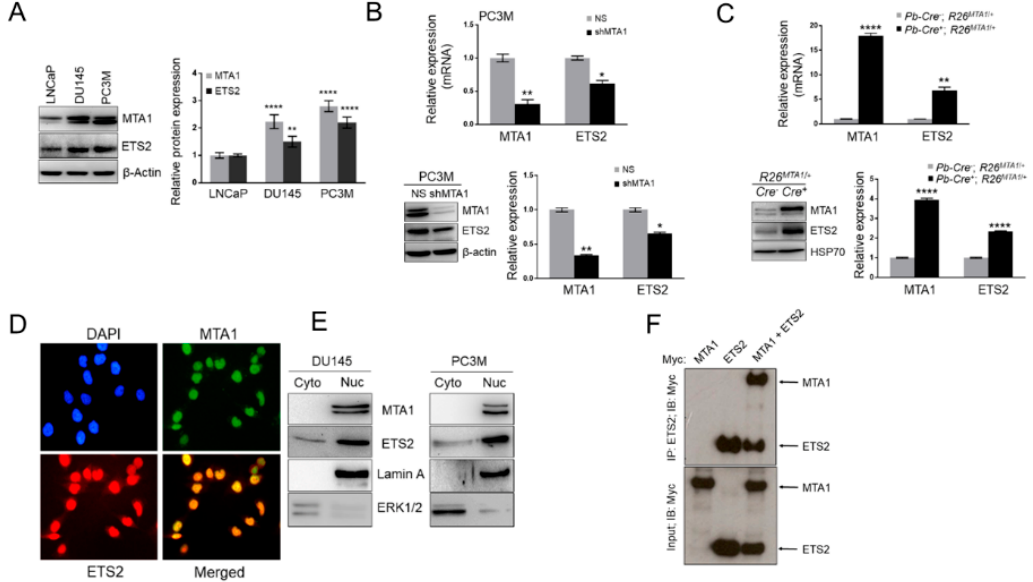
Figure 5. Erythroblastosis E26 transformation-specific 2 (ETS2) expression correlates with MTA1 in PCa. ( A ) ETS2 expression positively correlates with MTA1 expression in human PCa cell lines. ( B ) MTA1 and ETS2 mRNA ( top ) and protein ( bottom ) levels were analyzed in PC3M (NS) and silenced for MTA1 (shMTA1) cells by qRT-PCR and Western blot, respectively. Quantifications represent the mean ± SEM of three independent experiments. * p < 0.05; ** p < 0.01; **** p < 0.0001 (two-way ANOVA). ( C ) Quantitation of MTA1 and ETS2 mRNA ( top ) and protein ( bottom ) levels in prostate tissues (n = 3) of 13-week-old Pb-Cre + , R26 MTA1 /+ mice, and Cre-negative normal prostate control. Data represent the mean ± SEM of three prostate tissues. * p < 0.05; ** p < 0.01; **** p < 0.0001 (two-way ANOVA). ( D ) MTA1 and ETS2 protein expression was analyzed by immunofluorescence. Images were pseudo-colored in green to represent MTA1 and in red to represent ETS2. Images show the co-localization of MTA1 and ETS2 (merge, yellow) (magnification x 200). ( E ) Subcellular localization and predominantly nuclear expression of MTA1 and ETS2. Lamin A and Erk1 / 2 levels were used as a loading control for nuclear and cytoplasmic fractions, respectively. ( F ) MTA1 interacts with ETS2 in an ectopic system. A549 cells were co-transfected with Myc-MTA1, Myc-ETS2, and Myc-MTA1 + Myc-ETS2, and cell lysates were immunoprecipitated with antibodies to ETS2, followed by Western blotting with Myc antibodies.